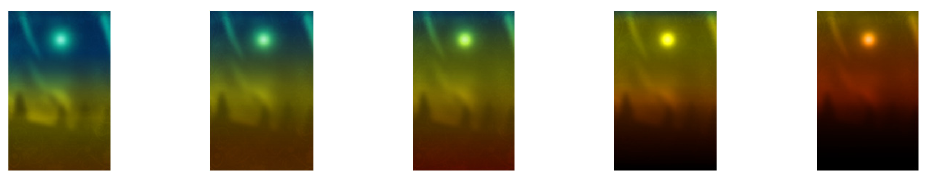
Figure 7. Sequence of background images as emissions increase.